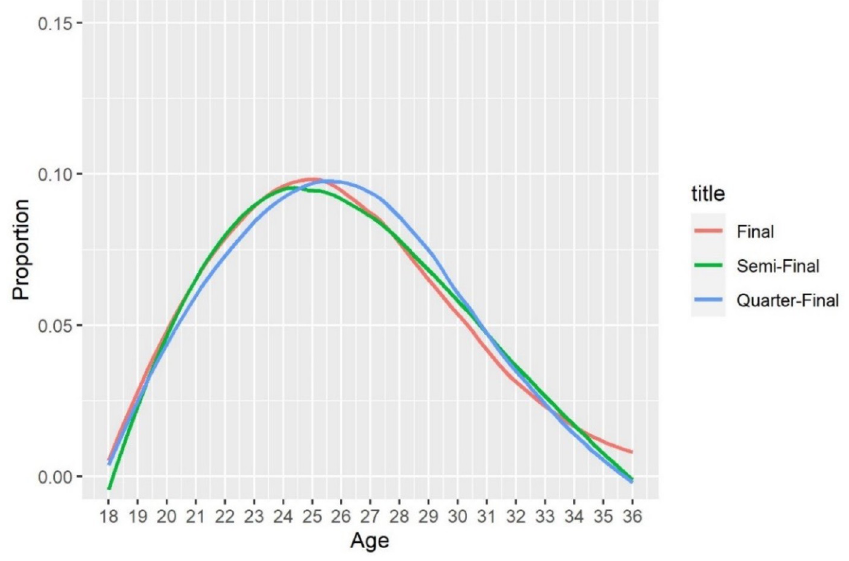
Fig 5. Age structure of players advancing to different rounds (male